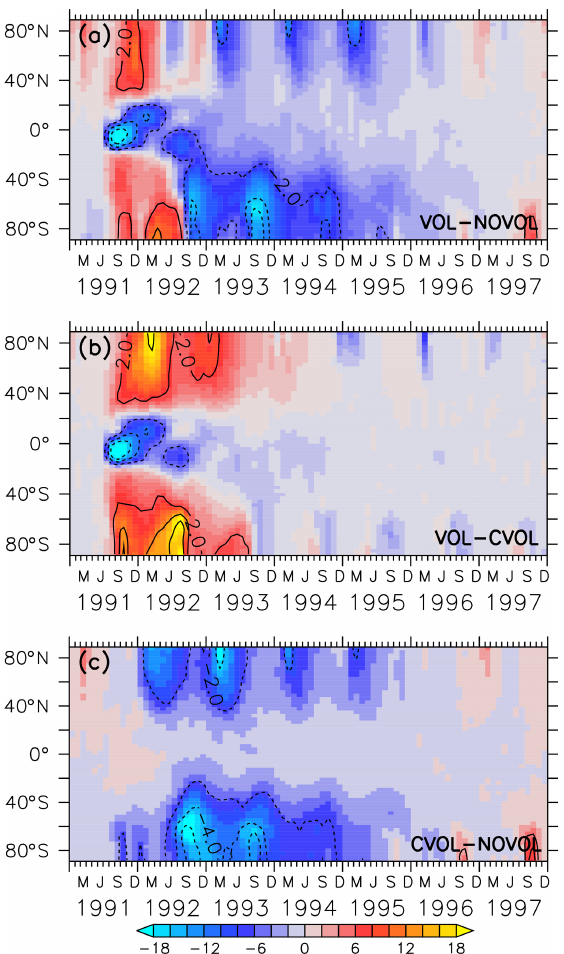
Figure 6. Colours show the differences in the zonal mean total ozone column (DU) as combined effect (VOL − NOVOL) (a) , heating effect (VOL − CVOL) (b) , and chemical effect (CVOL − NOVOL) (c) as a function of the latitude in degrees ( ◦ ). Contours indicate the corresponding relative changes (%). Contour intervals are